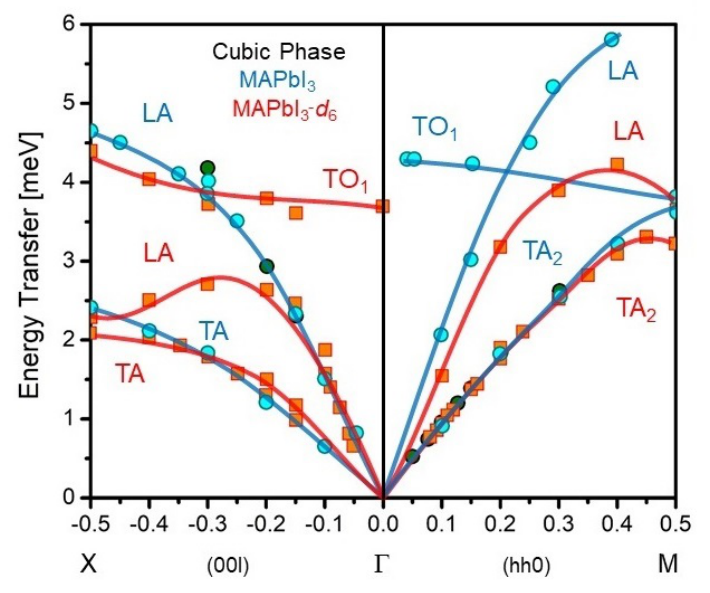
Figure 4. Phonon dispersion relations in the cubic phase of MAPbI 3 , measured on both perdeuterated and hydrogenous single-crystals using IXS (cyan circles [123]) and INS-TAS (orange squares [109] and green circles [113], respectively). Wave vectors on the abscissa are given in reduced lattice units. Longitudinal and Transverse Acoustic (LA and TA, respectively) branches are presented along with the lowest-energy Transverse Optical (TO) mode. Adapted with permission from Ref.